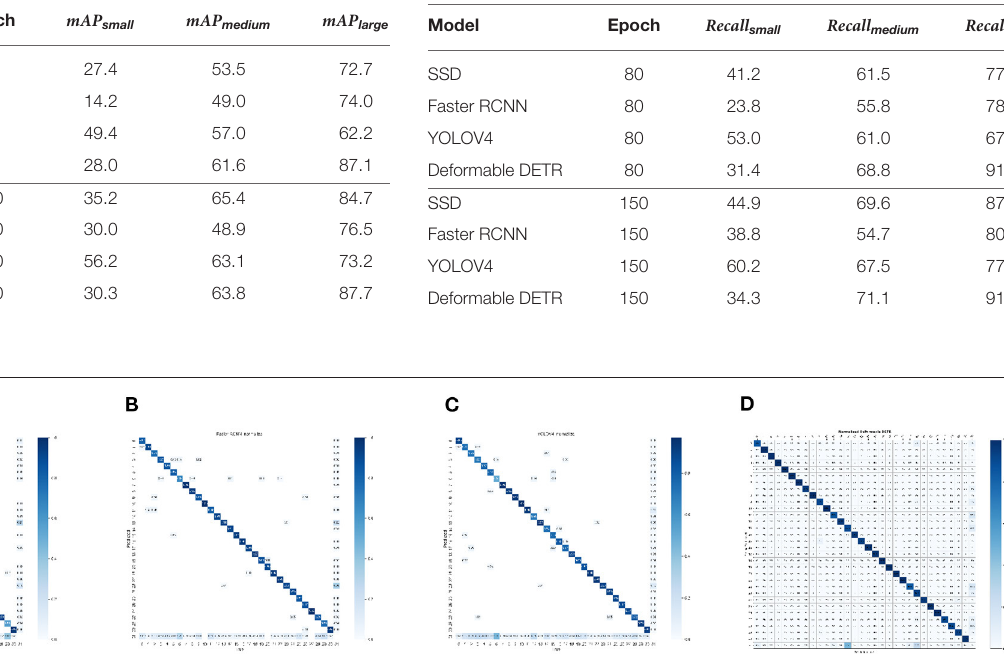
FIGURE 5 | Confusion matrix of the mo del on the test set. Epoch = 150, Iou-threshold = 0.5, Index = 31 means background. (A) SSD, (B) Faster RCNN, (C) YOLOV4, and (D) Deformable DETR.